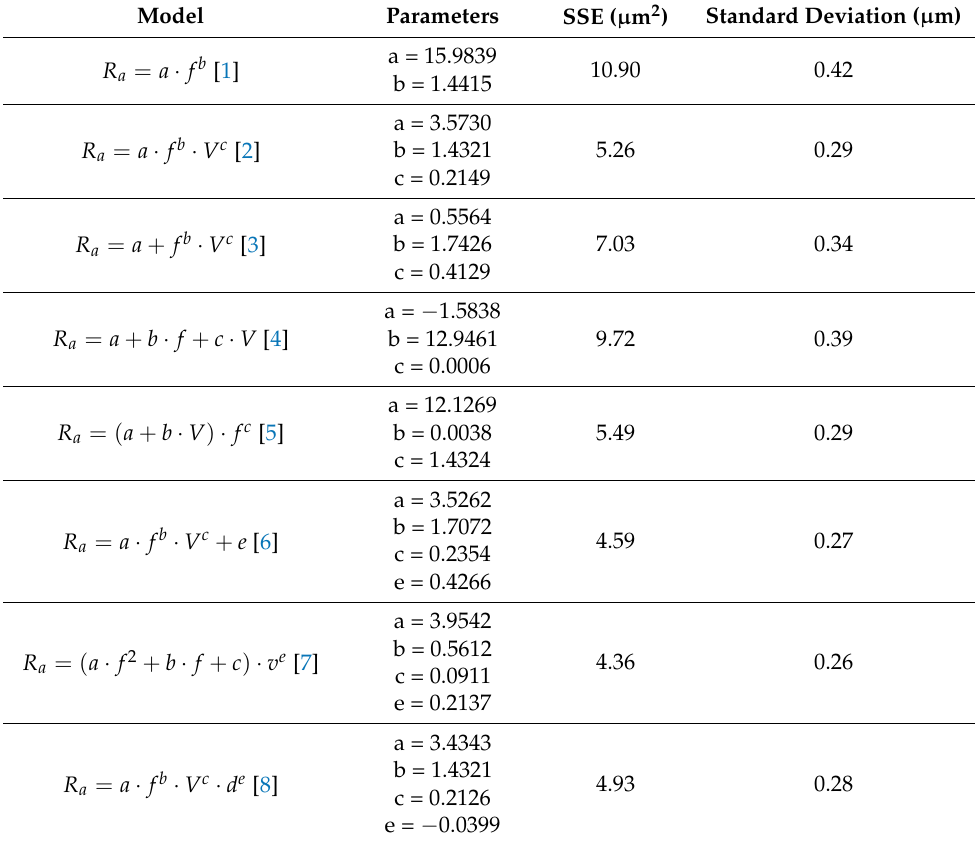
Table 5. Predictive models for arithmetic average roughness under LIL conditions. V (mm/s), f (mm/rev) and d (mm). SSE is the sum of squared error.